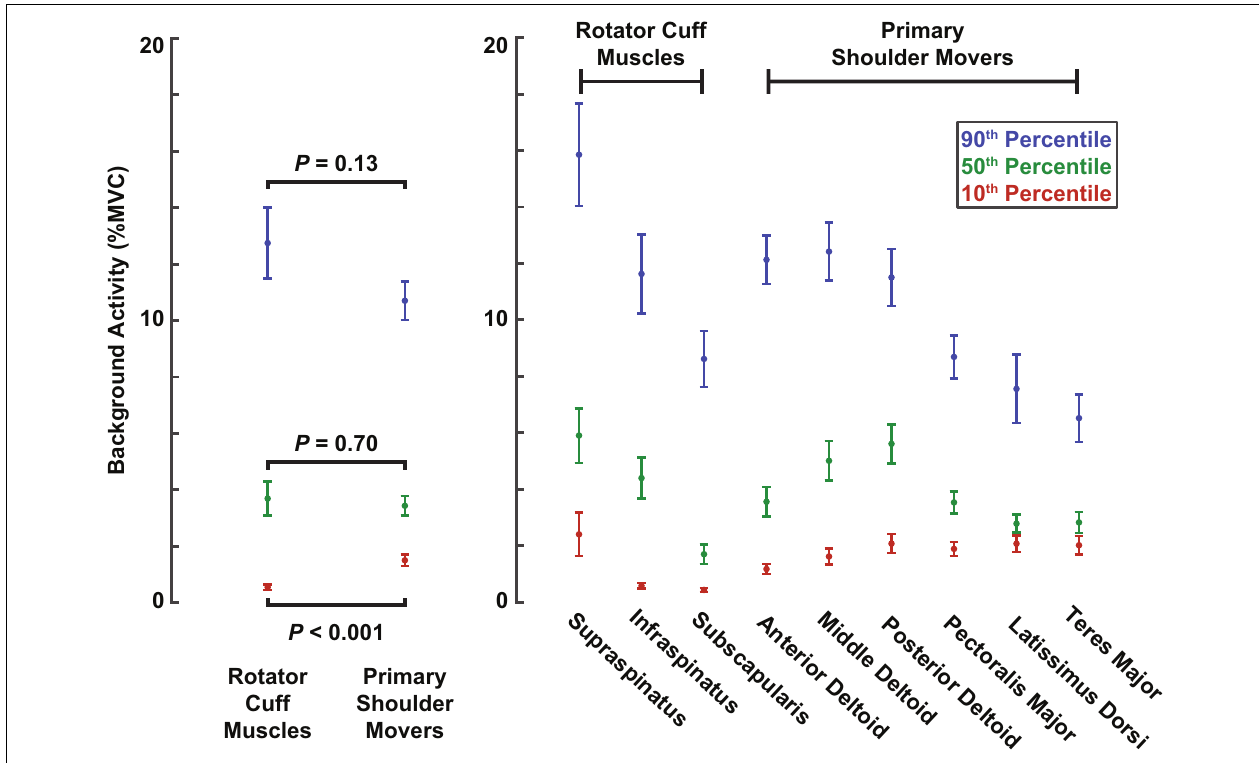
FIGURE 5 | Background activity comparing muscle groups and individual muscles. Colored dots represent background activities corresponding to the 10th (red), 50th (green), and 90th (blue) percentiles across all trials with torque levels of 10% MVC. Error bars represent the standard errors of each estimate.